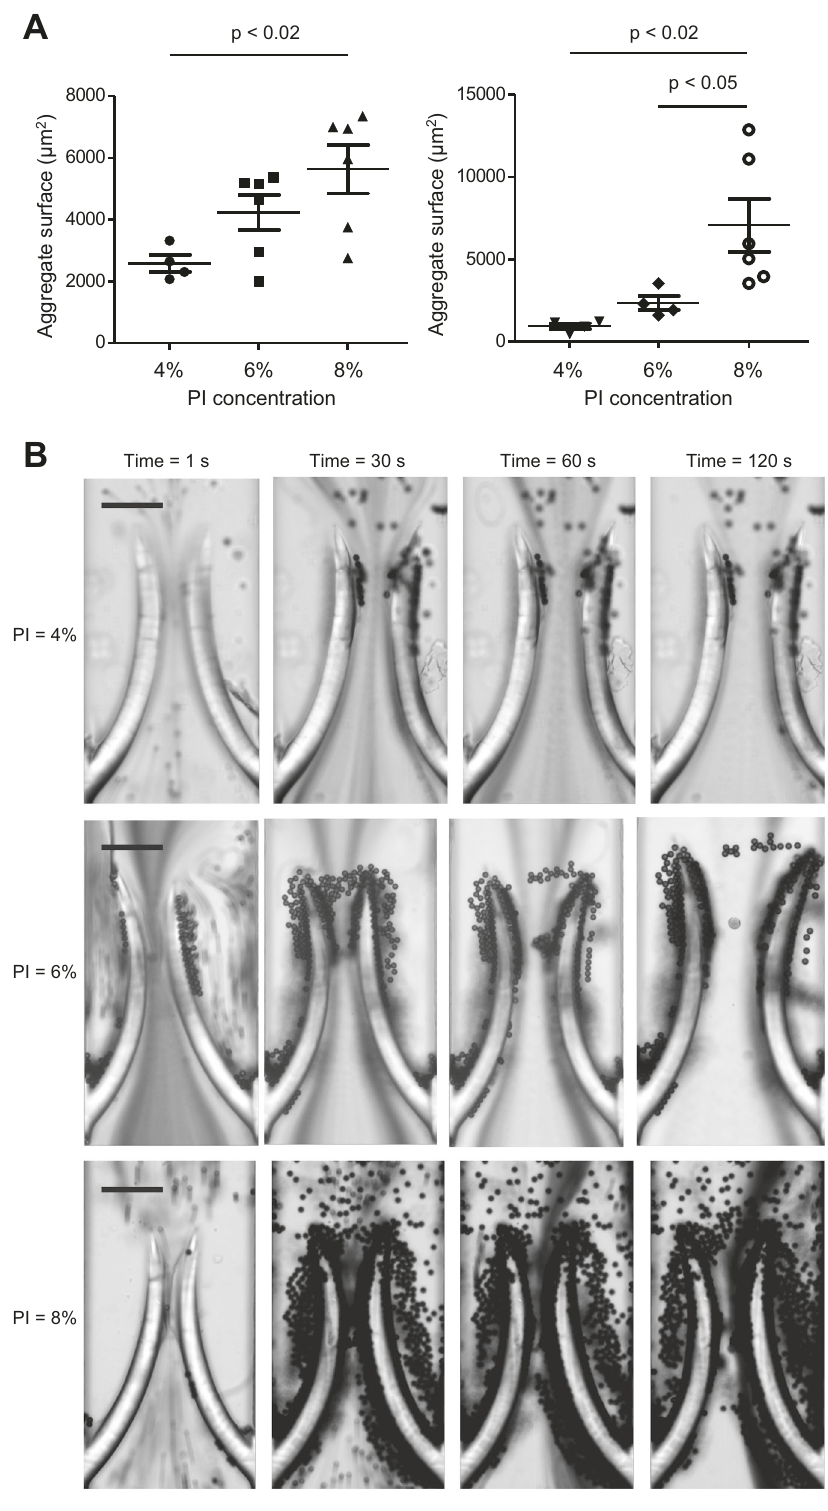
Fig. 4 Accumulation behaviour for valves of different stiffness. a Positive correlation between valve stiffness and size of the aggregate formed by the accumulation of polystyrene particles of 3 µ m (left, 0.1% w/v) and 10 µ m (right, 1% w/v) in diameter in the case of symmetrical valve rigidity and pulsed fl ow condition (0 – 100 mbar, 1 Hz). The valves were made of 50% [PEGDA] and, 4, 6, or 8% [PI], respectively from softer to stiffer. The data were analysed statistically using one-way ANOVA followed by Tukey post hoc test. b Typical accumulation behaviour over time for 10 µ m polystyrene particles (1% w/v) in diameter in the case of symmetrical valve rigidity and pulsed fl ow condition (0 – 100 mbar, 1 Hz). The scale bars represent 100 µ